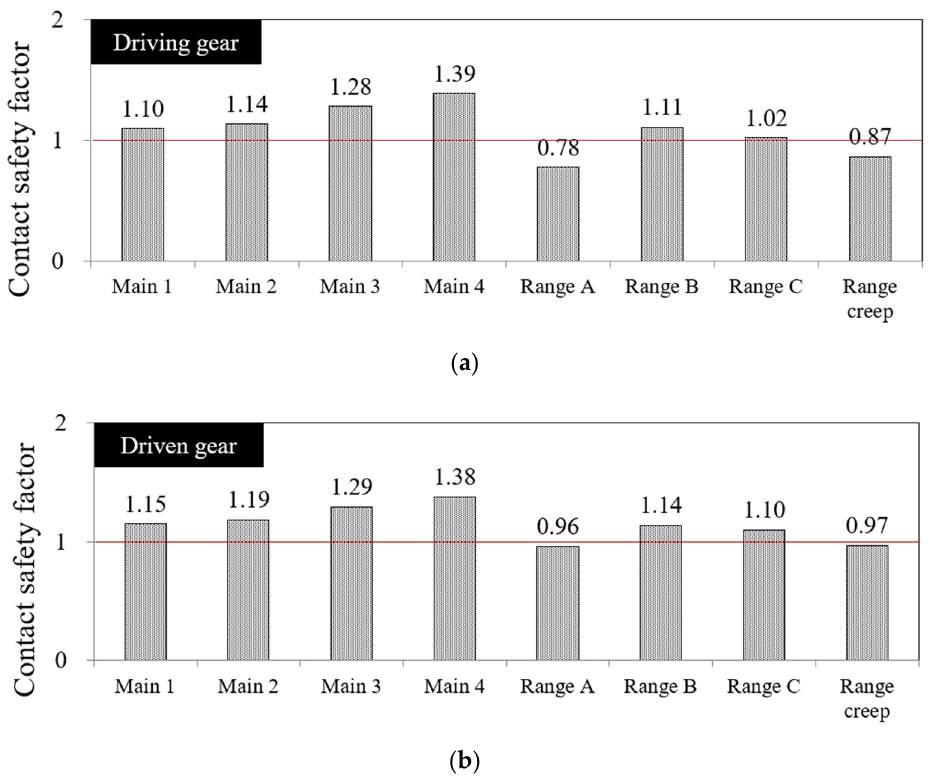
Figure 8. Results of contact safety factor for gears of the 86 kW class agricultural tractor transmission